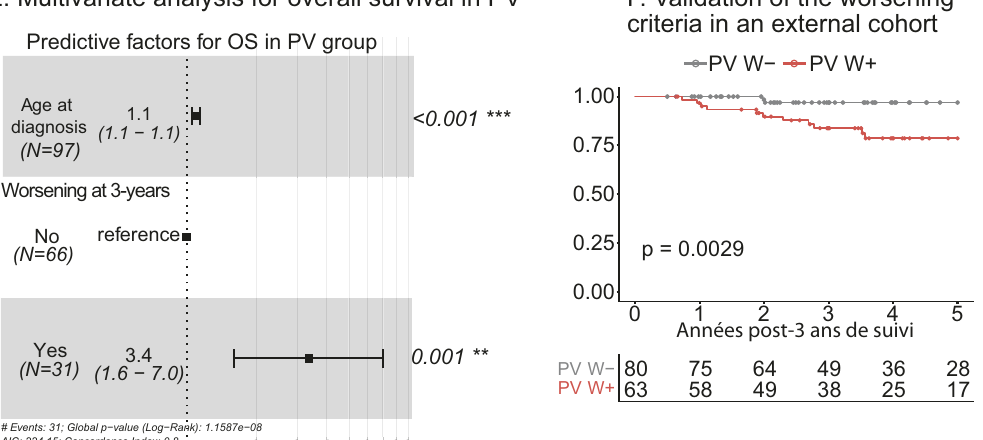
Fig. 1 Worsening at 3 years and long-term prognosis. A Flow-chart representing the design of the JAKSUIVI study. B Distribution of items for the worsening criteria at 3 years of follow-up. C Kaplan – Meier curve represents overall survival according to the diagnosis (ET: essential thrombocythemia, PV: polycythemia vera) and the worsening status (W + : worsened at 3 years, W − : not worsened). Starting time t0 was the 3 years (3 y) follow-up (FU). D Kaplan – Meier curves for the landmark analysis of overall survival in PV patients. The top plot represented the follow-up of the fi ve fi rst years after the 3-year evaluation and the bottom plot represented the follow-up from 5 to 7 years after the 3-year evaluation with a t0 at 5 years. E Forest plot representing the results of multivariate Cox analysis for overall survival in PV. F Kaplan – Meier curve represents overall survival according to the worsening status in the validation